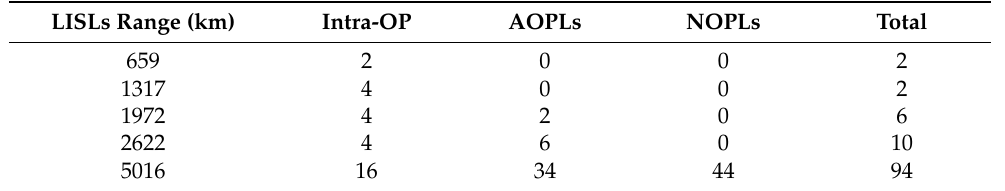
Table 3. Number of permanent LISLs at different visual distance ranges.